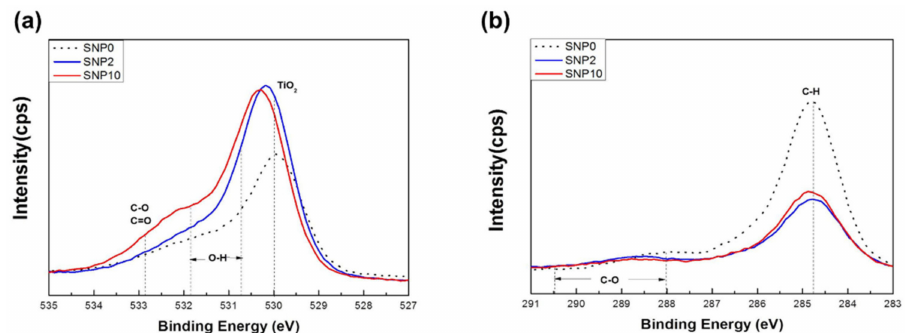
Figure 5. X-ray photoelectron spectroscopy (XPS) analyses on titanium surface before NTAPPJ treatment (SNP0), following 2 min of NTAPPJ treatment (SNP2) and following 10 min of NTAPPJ treatment (SNP10) with detailed spectra for O1s ( a ) and C1s ( b